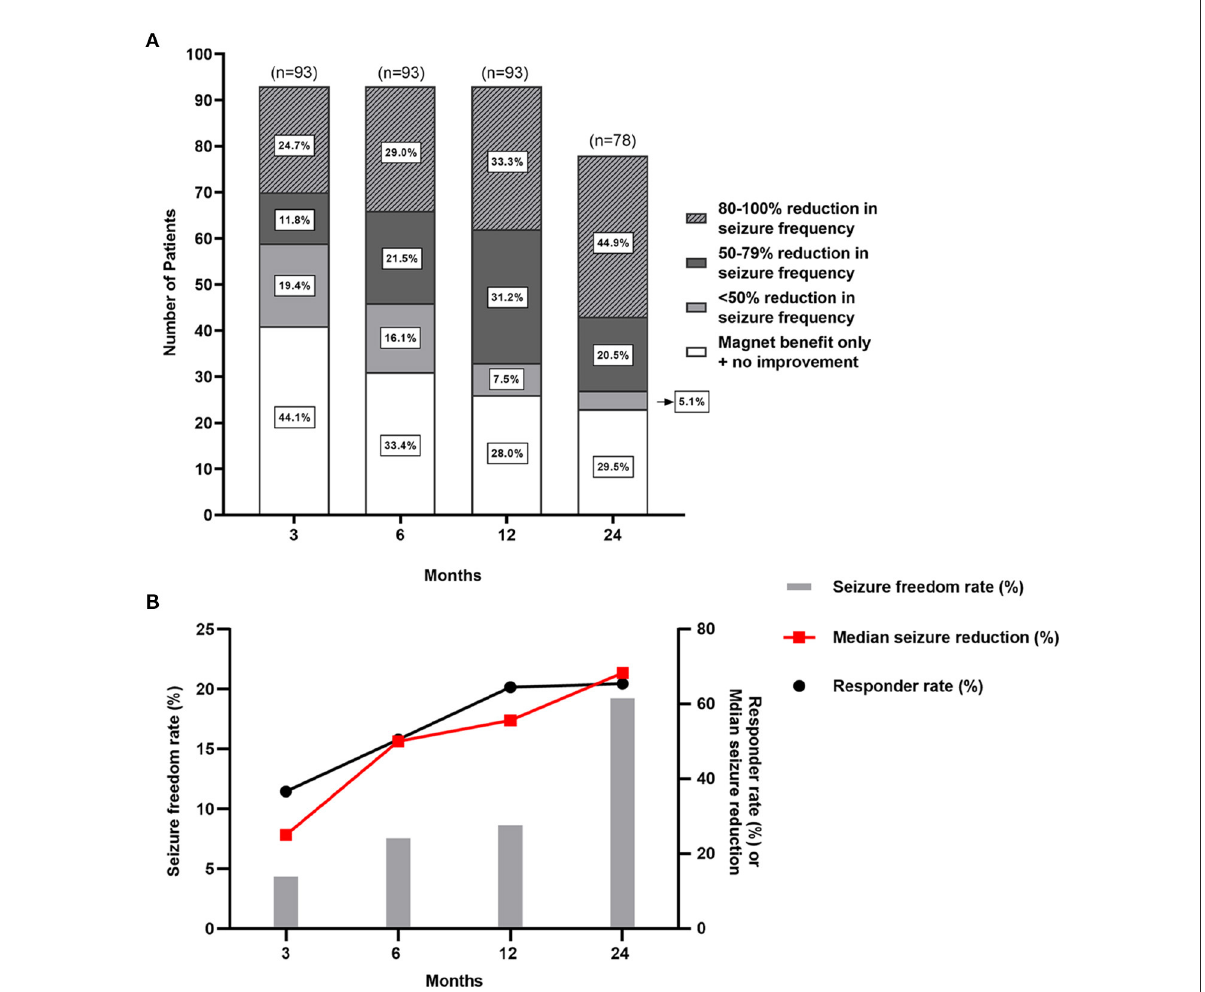
FIGURE3 Seizure outcomes of patients with pharmacoresistant epilepsy secondary to encephalomalacia after VNS. (A) There are seizure outcomes at 3-, 6-, 12-, and 24-month follow-up after VNS therapy with McHugh outcome classification. (B) The responder rate, seizure freedom rate, and median reduction of seizure frequency gradually increase over